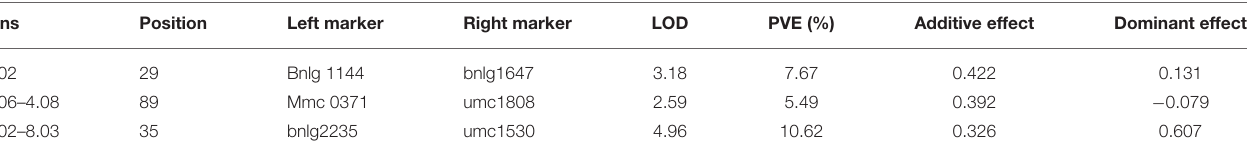
TABLE 3 | QTLs for maize stalk